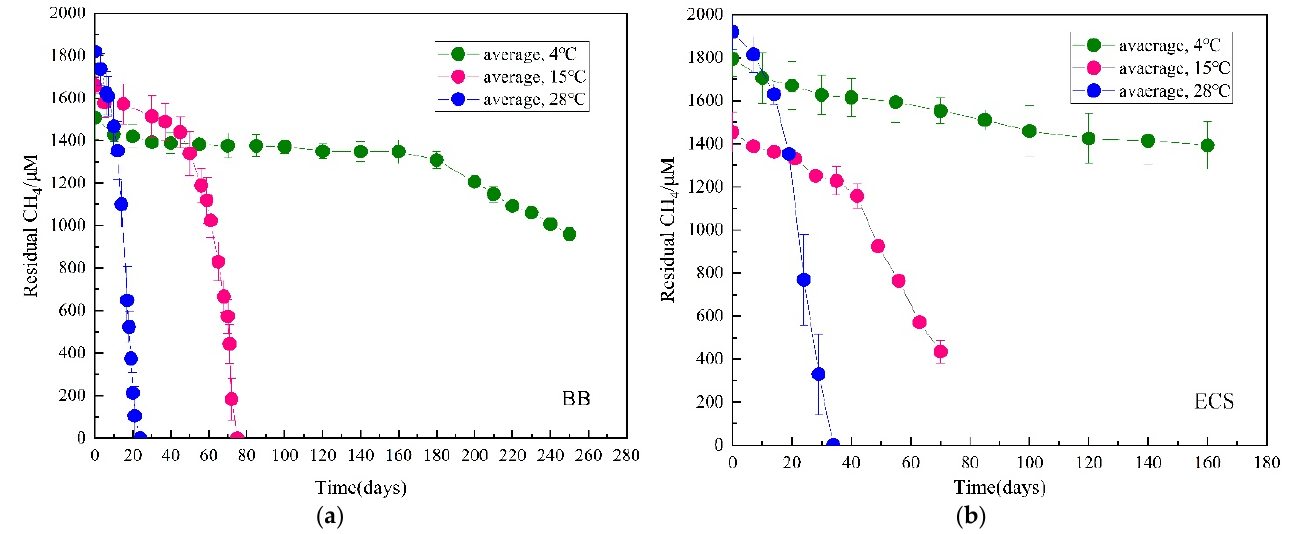
Figure 2. CH 4 consumption over incubation time at different temperatures with BB ( a ) and ECS ( b ) sediments. Values represent means of duplicate incubations ±SD. Table 2. Potential CH 4 oxidation rates ( µ mol gdw − 1 d − 1 ), Mean ( R 2 ), Q 10 values, and one-way ANOVA.